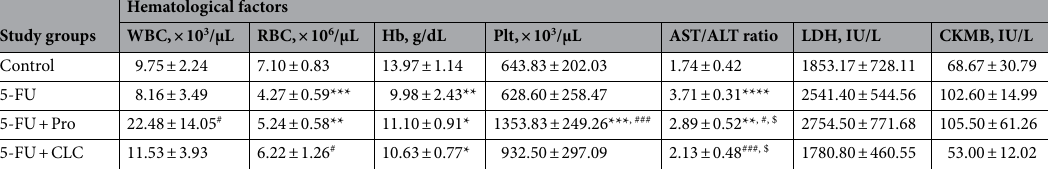
Table 3. Hematological factors of study groups. Values are expressed as mean ± standard deviation (SD). Groups: Control, Normal saline; 5-FU, 5-FU 125 mg/kg; 5-FU + Pro, 5-FU 125 mg/kg + Propolis ethanolic respectively). # , and ### Indicate statistically significant difference compared to the 5-FU group (p < 0.05, and p < 0.001, respectively). $ Indicate statistically significant difference between the treatment groups (p < 0.05).